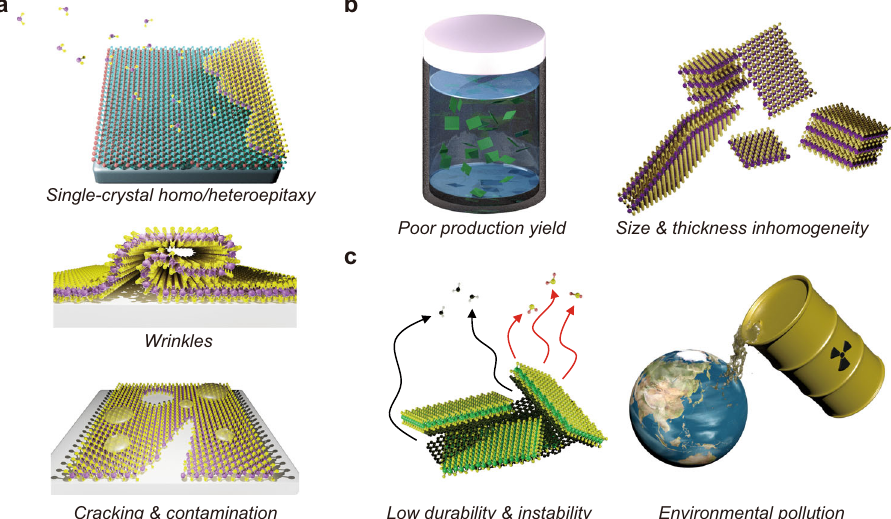
Fig. 3 Current challenges in the mass production of 2D materials. a Single-crystal homo/heteroepitaxial growth, wrinkle formation by thermal expansion coef fi cient mismatch between 2D materials and growth substrates, and cracking/contamination during the transfer process are all issues presented by the CVD technique. b Inhomogeneous size and thickness of 2D nanosheets and poor production yield are problems associated with liquid exfoliation. c Low durability and instability of 2D materials by defects and environmental pollution remain challenges for wet chemical